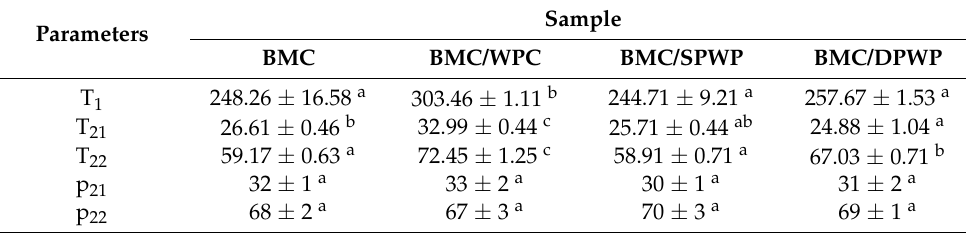
Table 2. Molecular dynamics and water activity of buttermilk cheeses with polymerized whey protein.